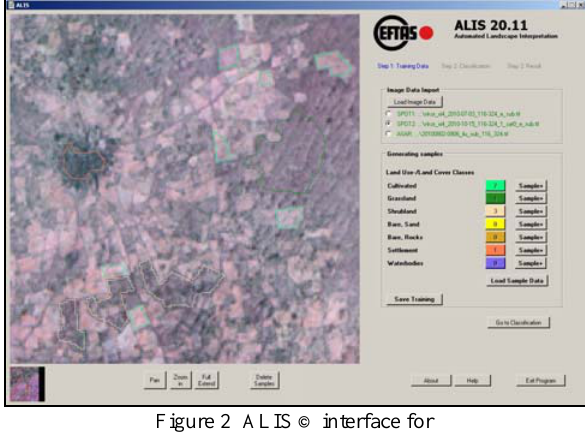
Figure 2 ALIS © interface for the GMFS CuA processing.